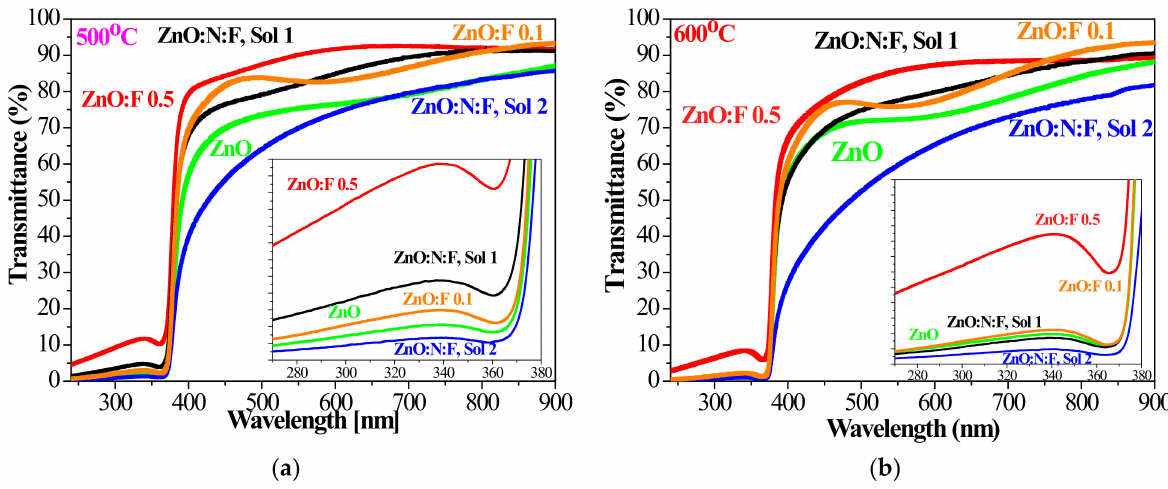
Figure 7. Comparison of the transmittance spectra of ZnO, ZnO:F and ZnO:N:F films, annealed at ( a ) 500 and ( b ) 600 ◦ C in the spectral region 280–900 nm. The inset figures show the excitonic feature of the studied films. Table 2. The average values of transmittance and reflectance of the studied sol-gel films, determined for the visible spectral range 450–750 nm. The average transmittance of bare quartz substrate is 93.53%. 300 ◦ C 400 ◦ C 500 ◦ C Material